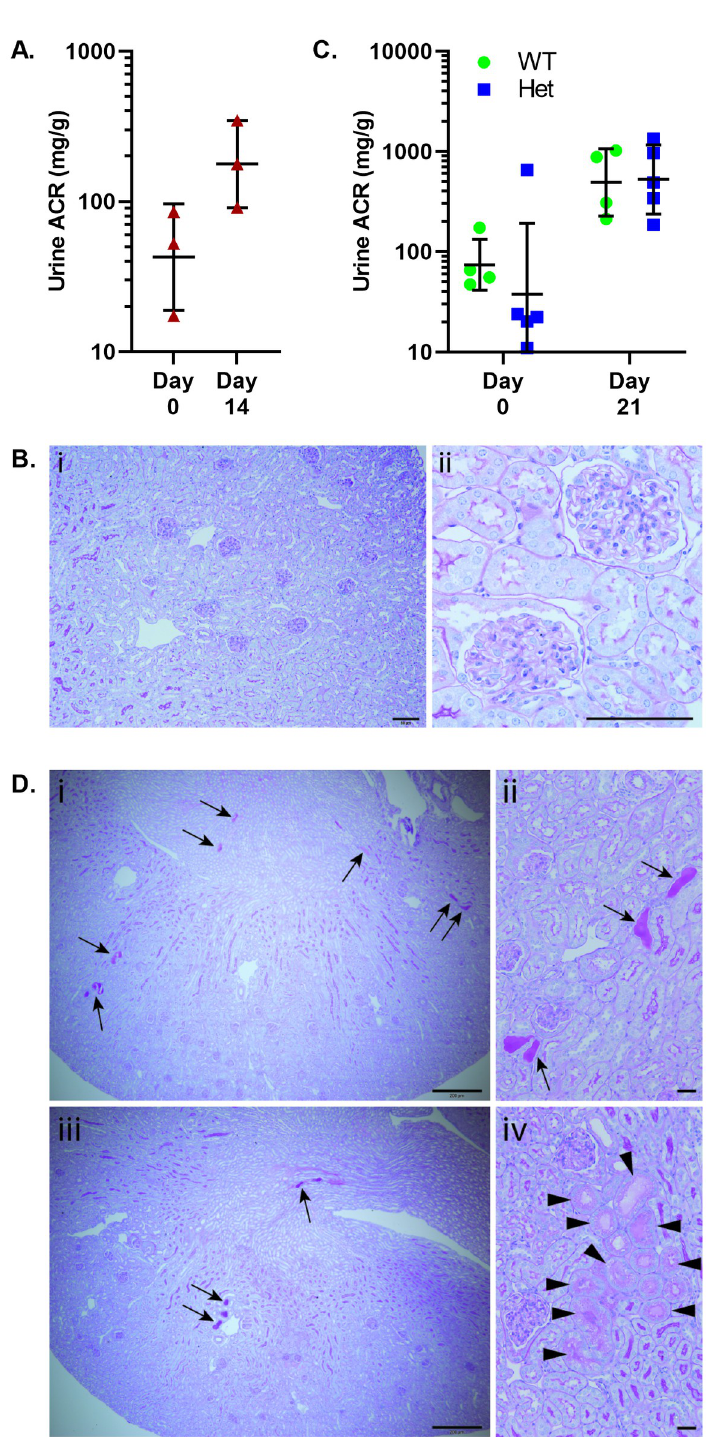
Fig 2. Puromycin aminonucleoside nephrosis in Trpc6 E896K mutant mice. Various Trpc6 genotype male mice were subject to two intraperitoneal injections of puromycin aminonucleoside (PA; 450mg/kg) on days 0 and 7. Trpc6 E896K/E896K mice on the FVB background developed a small ( < 5fold) increase in albuminuria at day 14 compared to baseline (A). B, PAS stained histology sections of Trpc6 E896K/E896K kidney 14 days after PAN revealed no appreciable (i) cortical, or (ii) glomerular, pathology.Scale bar represents 50 μ m.C, urinary albumin-to-creatinine ratios (ACR) of Trpc6 +/+ (WT) and Trpc6 +/E896K (Het) animals on an F1 FVB/NJ x Sv/129 background before and 21 days after PAN induction. D, PAS stained WT (i, ii), and Het (iii, iv) kidney sections 21 days after PA administration demonstrate largely preserved cortical,